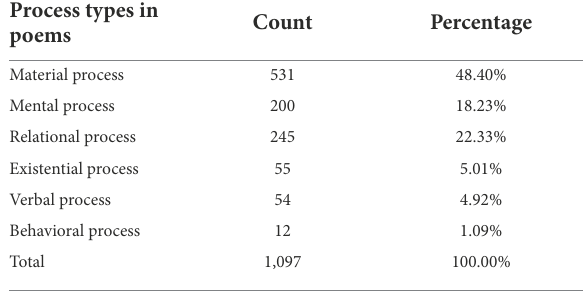
TABLE 2 Distribution of different processes in